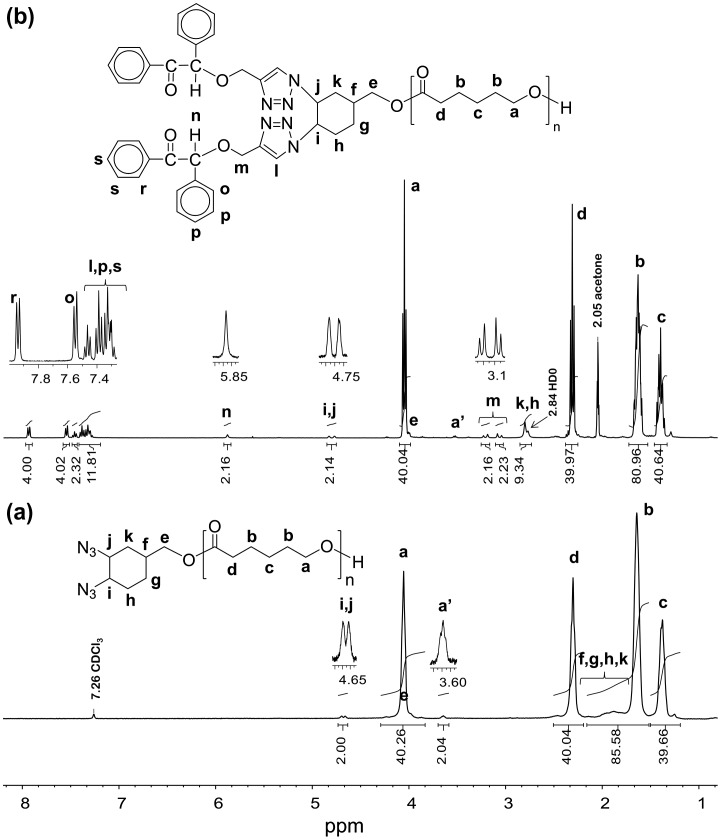

1H NMR spectra of PCL-(N3)2 (a) and PCL-(PI)2 (b) in deuterated acetone.